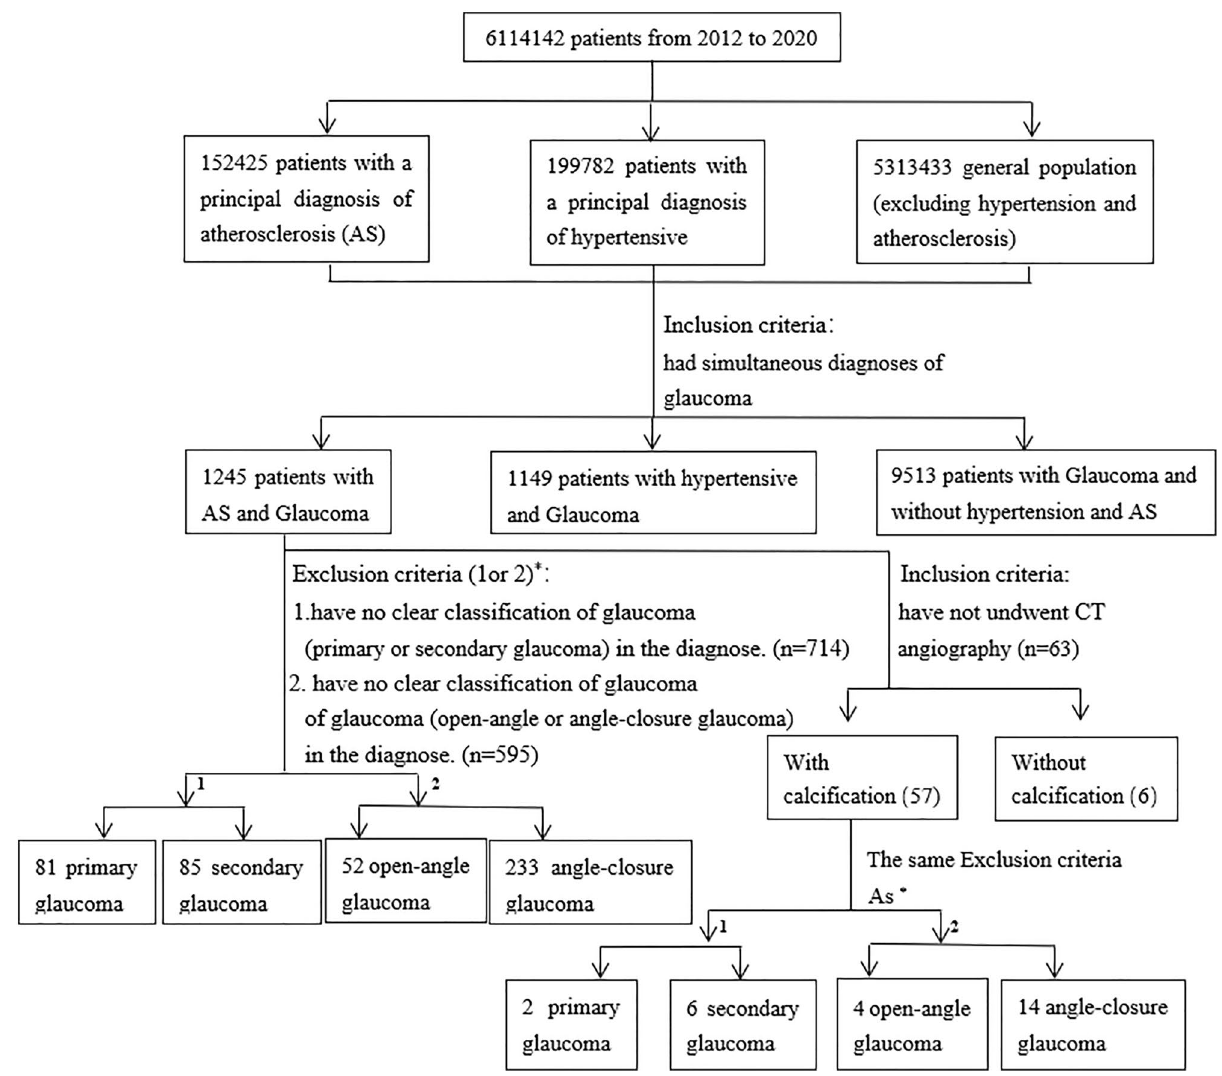
Figure 3. The analysis process of the morbidity of glaucoma in patients with